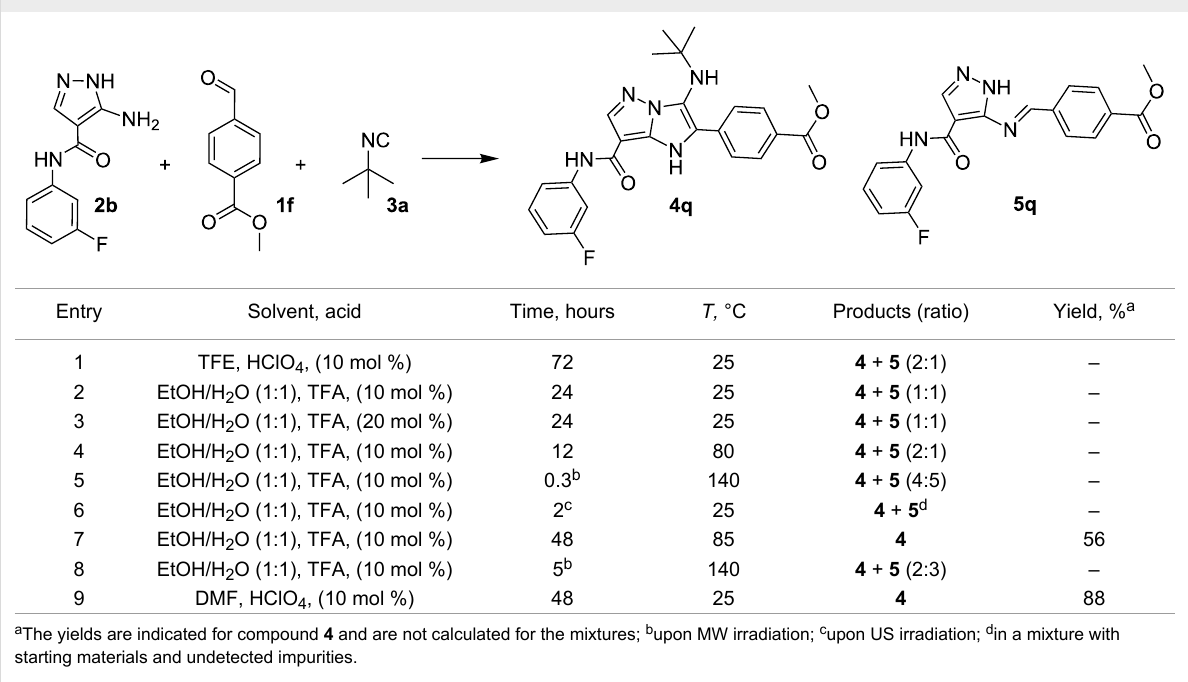
Table 2: Optimization of the reaction conditions for the synthesis of compound 4q .